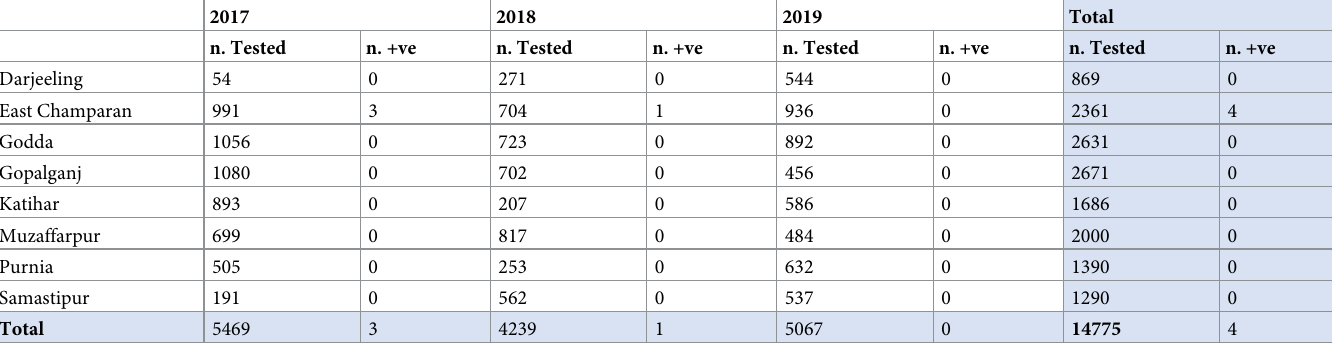
Table 3. Number of P . argentipes with positive L . donovani detection at each sentinel site by